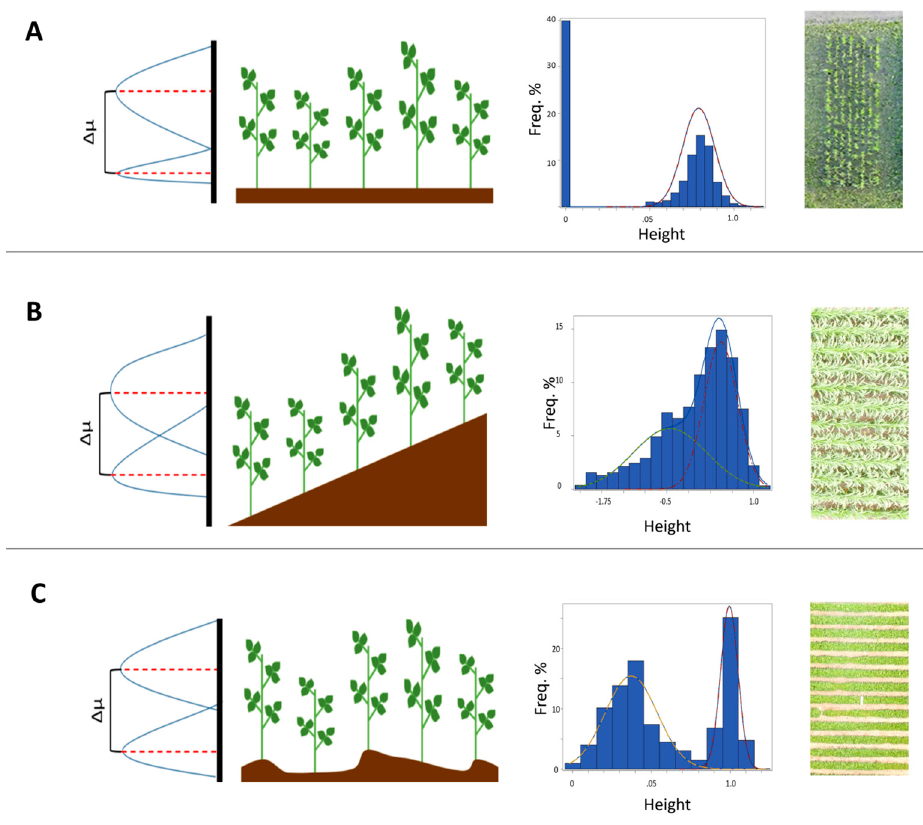
Figure 6. Topography differences do not affect the difference of μ 1 and μ 2 when estimating height using a finite mixture model (FMM). Height variance changes dependent on both elevation and plant height variation, but this is independent of the difference between μ 1 and μ 2 . Three scenarios are shown as schematics on the left and are accompanied by real FMM output histograms representing each scenario. Imagery from which FMM output was generated is shown at the right. Scenario (A): flat terrain represented by a rice plot; scenario (B): sloped terrain present in a grain sorghum field; scenario (C): the uneven terrain of a soybean field.